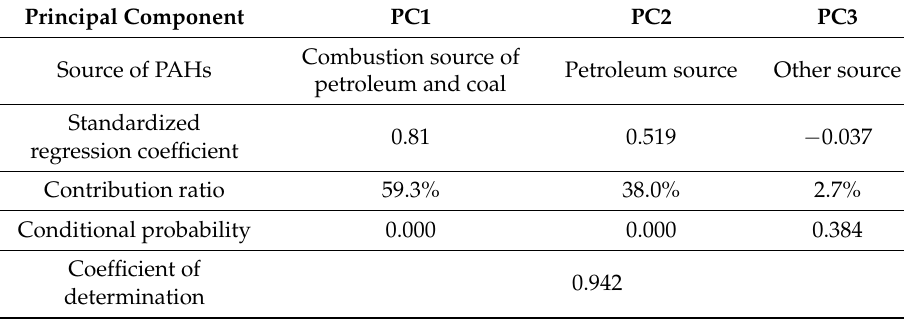
Table 4. Multiple linear regression (MLR)